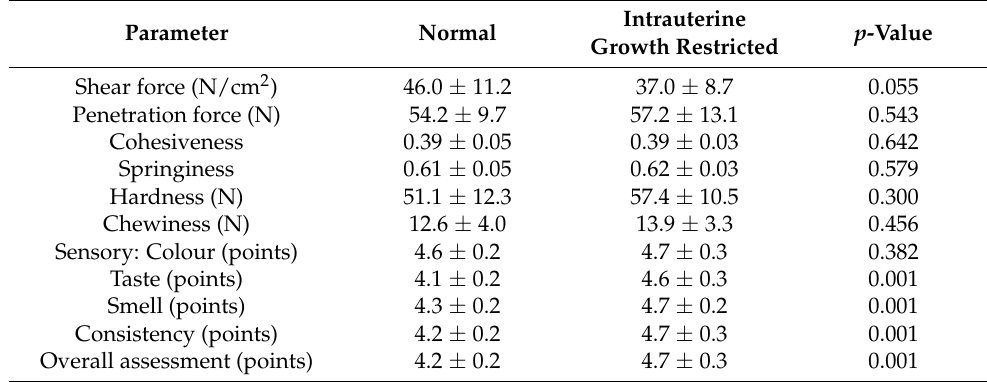
Table 5. Texture and sensory evaluation of meat of the normal ( n = 12) and intrauterine growth restricted ( n = 11) pigs. Mean ± SD, Student- t test.